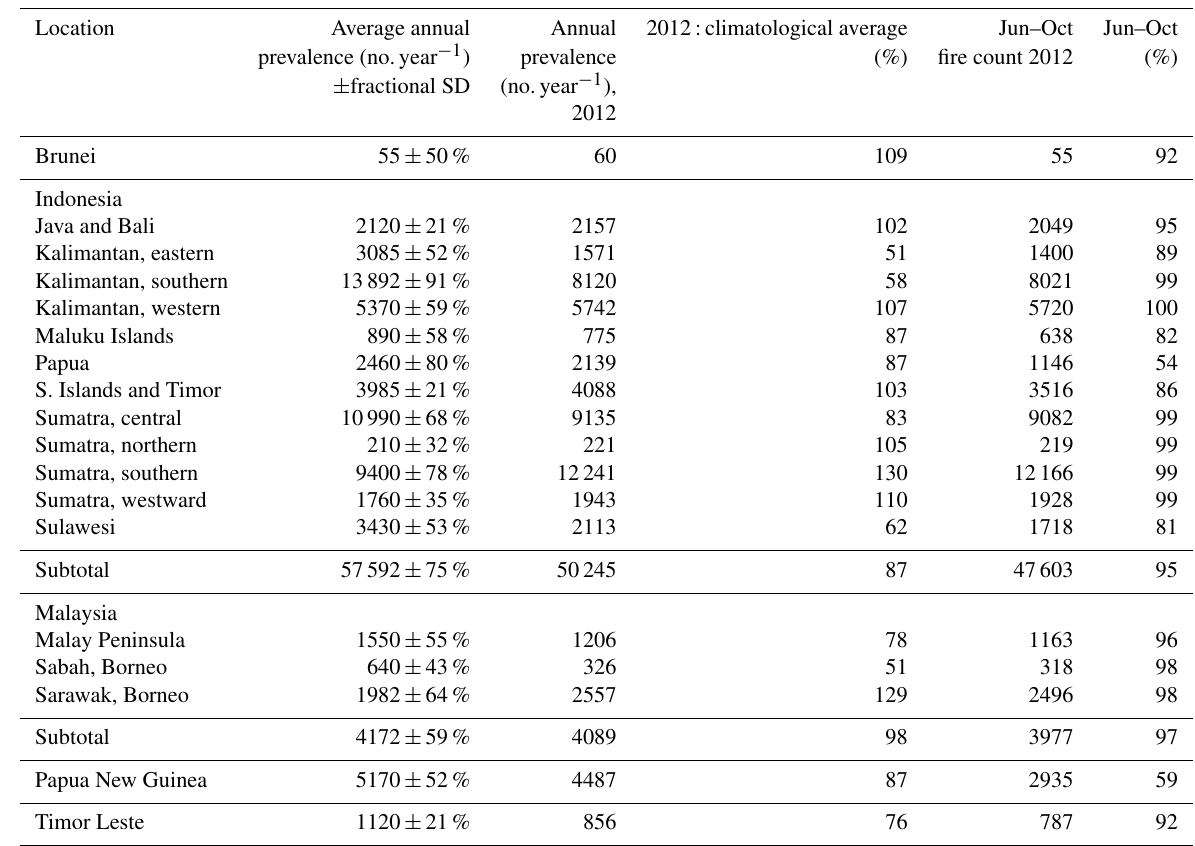
Table 1. 2012 Active fire hotspot prevalence from combined Terra and Aqua MODIS for key areas of the Maritime Continent. Included is the 2003–2009 average from Reid et al. (2012), the sum of all fire detections in 2012, the number in the June–October study period here, and the fraction of the 2012 total